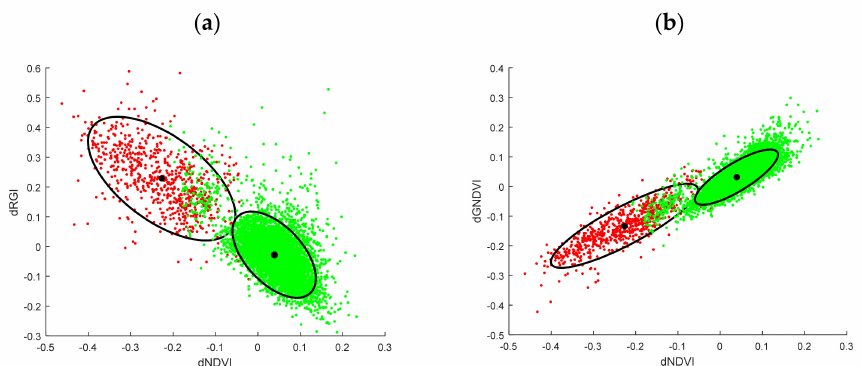
Figure 5. Distribution of dead trees (red) and healthy trees (green) in the indices feature space: ( a ) ∆ NDVI versus ∆ RGI and ( b ) ∆ NDVI versus ∆ GNDVI. The 90% confidence ellipse for each of the trees’ classes is drawn in